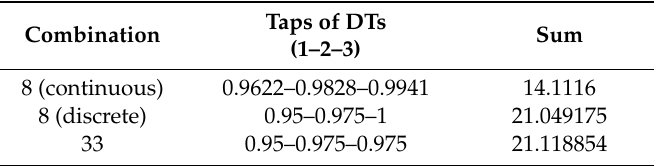
Table 3. Best adjustment of tap